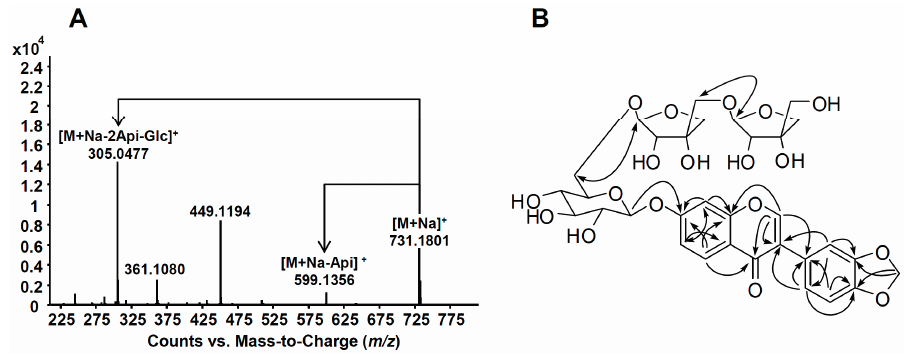
Figure 2. Q-TOF MS/MS ( A ) and HMBC correlations ( B ) of compound 1